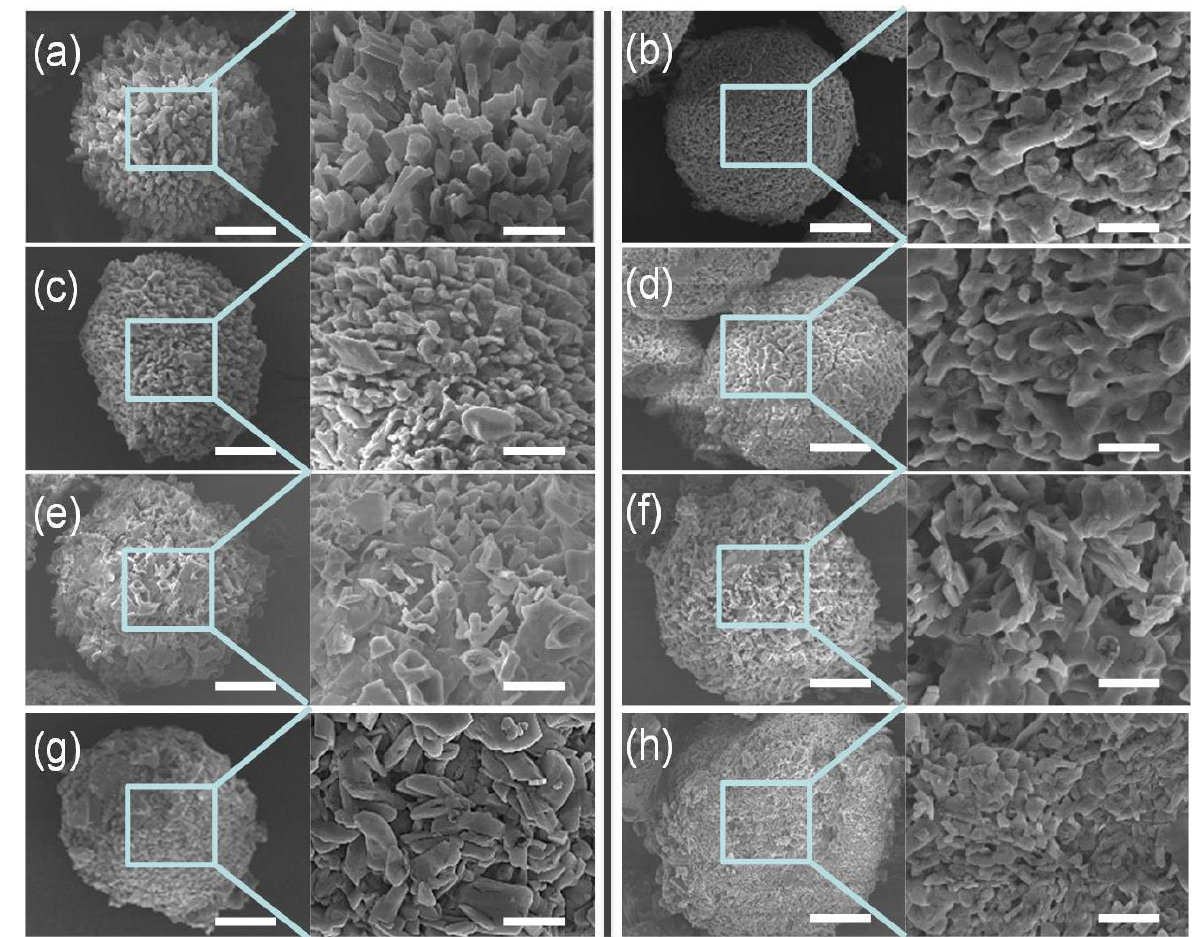
Figure 1. SEM images of the pollen-like mesoporous lactose particles with α : β ratios of ( a , b ) 1:0, ( c , d ) 3:7, ( e , f ) 5:5 and ( g , h ) 1:9, before and after ingredient loading. Scale bars: 5 μm ( a – h ) and 1 μm (enlarged images).